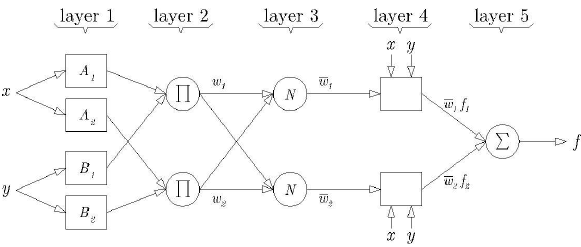
Figure 2: Schematic representation of a 3DOFs system under earth- quake excitation - Semi-active control with a MR damper at the first floor.